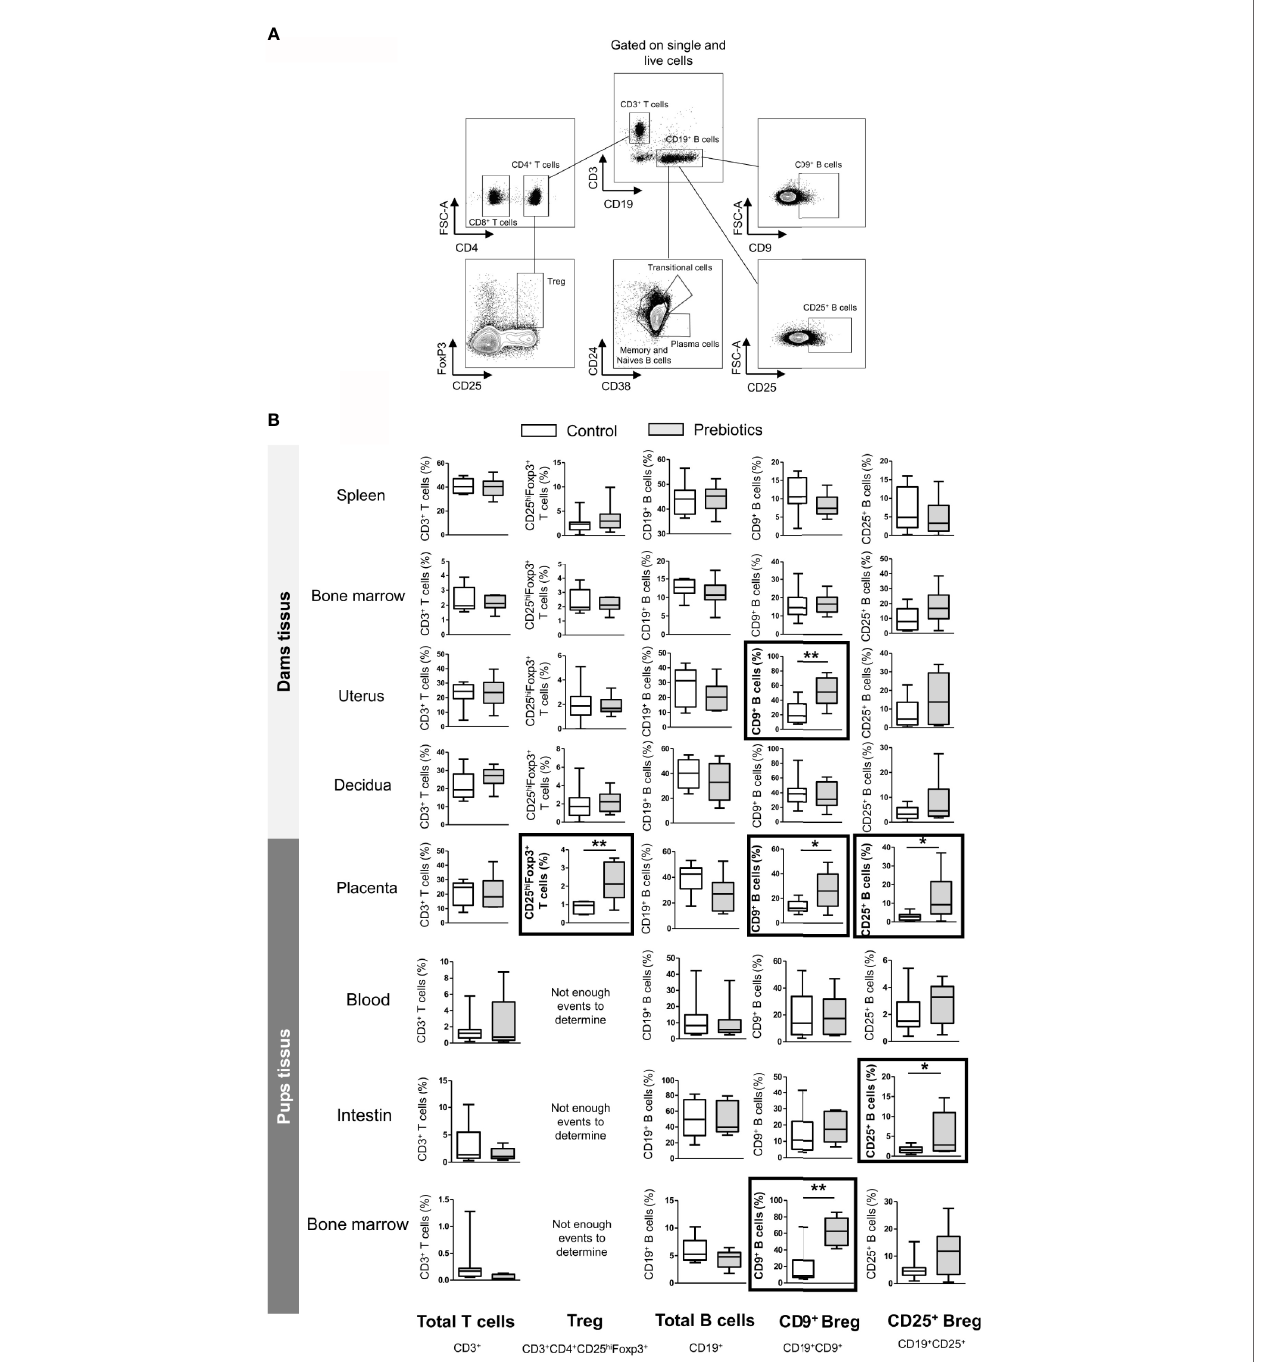
FIGURE 6 | Effects of GOS/inulin supplementation during pregnancy on B and T lymphocyte cell frequency in dams and fetuses. (A) Gating strategy used after immunostaining to evaluate all T and B lymphocyte subsets. (B) Assessment of total T and B cell, regulatory T cell (Treg) and regulatory B cell (CD9 + and CD25 + B cell) frequencies in tissues from dams and pups fed a control diet (white) or a diet supplemented with GOS/inulin (gray) (n=9) (* = p<0.05, ** =